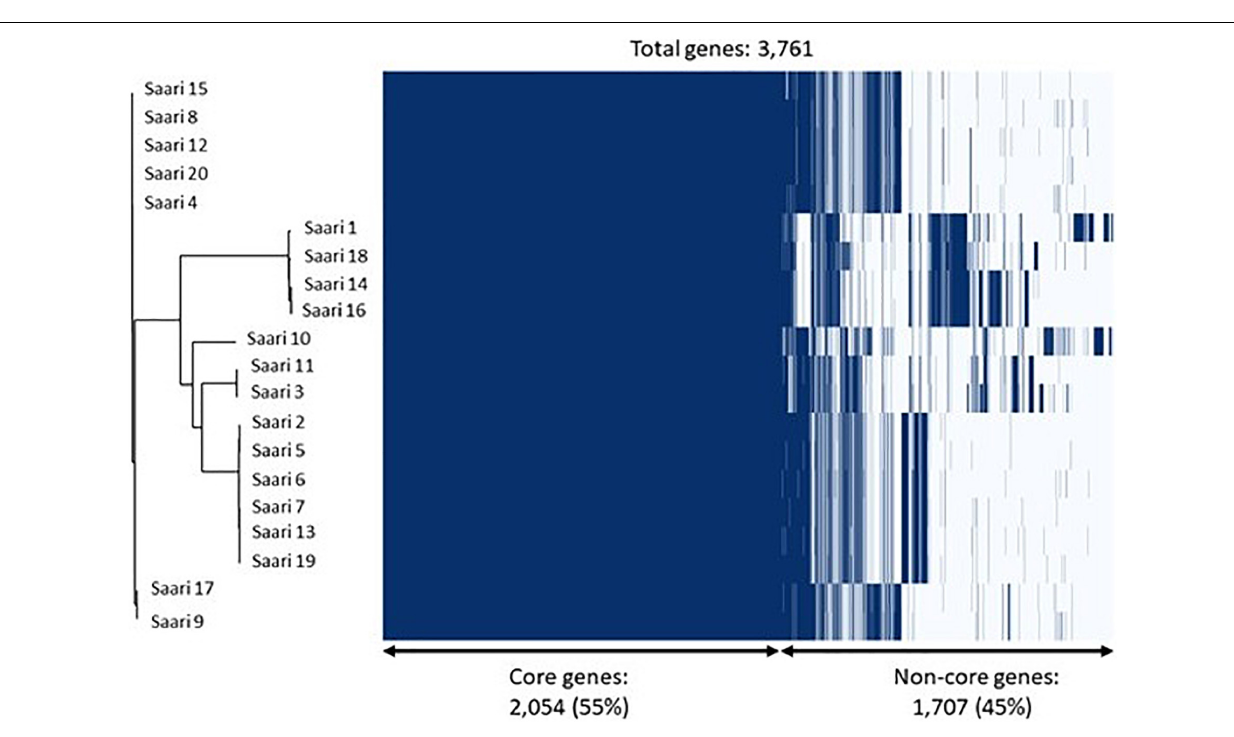
FIGURE 3 | Core-genome phylogeny and gene presence across Staphylococcus aureus isolates. On the left, a phylogenetic tree based on the core-genomes of the 20 S. aureus isolates is shown. On the right, a heatmap showing gene presence (dark blue) or absence (light blue) of annotated genes in each of the 20 isolates. The samples have been ordered according to the phylogenetic